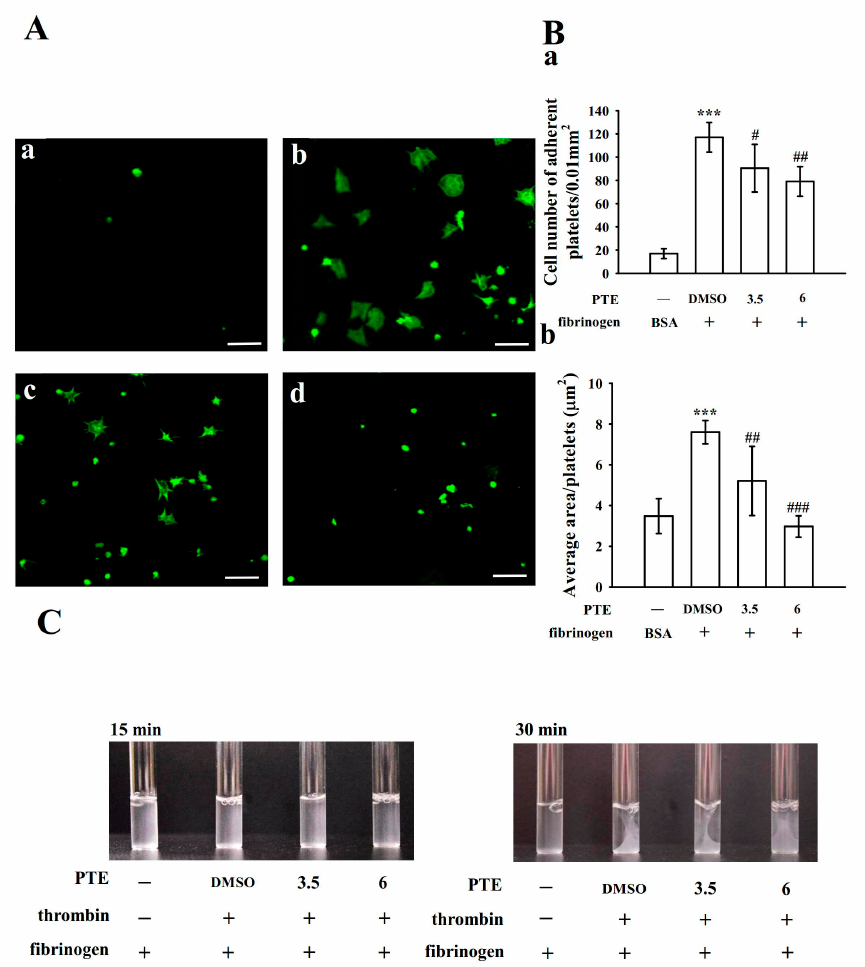
Figure 5. Inhibitory activity of pterostilbene (PTE) on platelet adhesion and spreading on immobilized fibrinogen as well as fibrin clot retraction. ( A ) Washed platelets were allowed to spread on the ( a ) BSA- or (b–d) fibrinogen-coated surfaces in the presence of the ( b ) solvent control (0.1% DMSO) or PTE ( c , 3.5 µ M; d , 6 µ M) and subsequently labeled with fluorescein isothiocyanate–phalloidin, as described in the Materials and Methods section. Scale bar, 10 µ m. Plot of ( B ) the number of adherent platelets per 0.01 mm 2 ( a ), and the average spreading surface area of individual platelets in six sight views ( b ). ( C ) Washed platelets (3.6 × 10 8 cells/mL) were suspended in Tyrode’s solution containing 2 mg/mL fibrinogen and 1 mM CaCl 2 with the solvent control (0.1% DMSO) or PTE (3.5 and 6 µ M). Clot retraction was initiated with thrombin (0.01 U/mL) at 37 ◦ C. Images were photographed at 15 and 30 min intervals by using a digital camera. Profiles in ( C ) are representative of four similar experiments. Data are presented as the mean ± standard deviation ( n = 4). *** p < 0.001, compared with the BSA (control); # p < 0.05, ## p < 0.01 and ### p < 0.001, compared with the 0.1% DMSO-treated